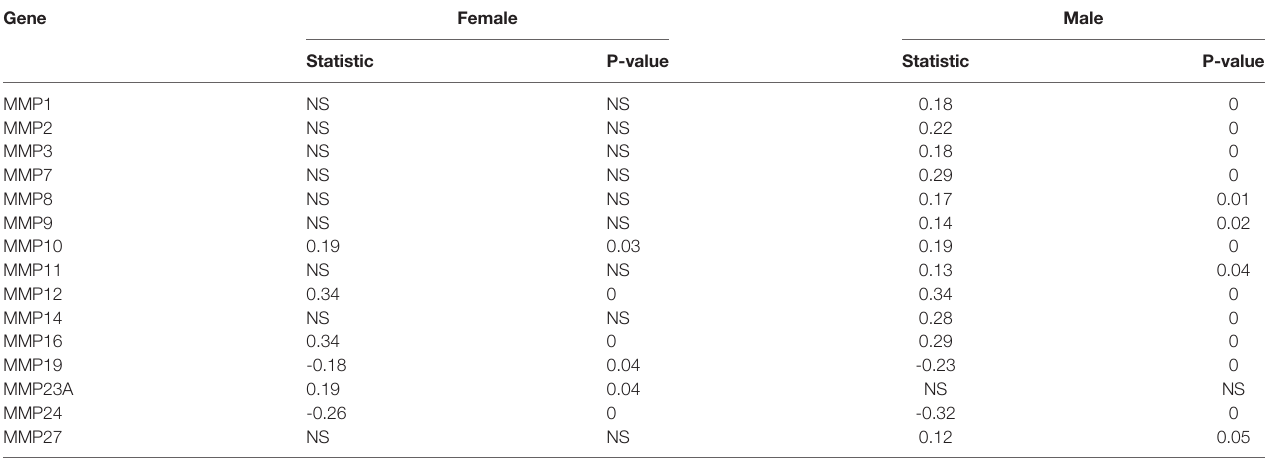
TABLE 2 | Relationship between MMPs and GMFB in male and female